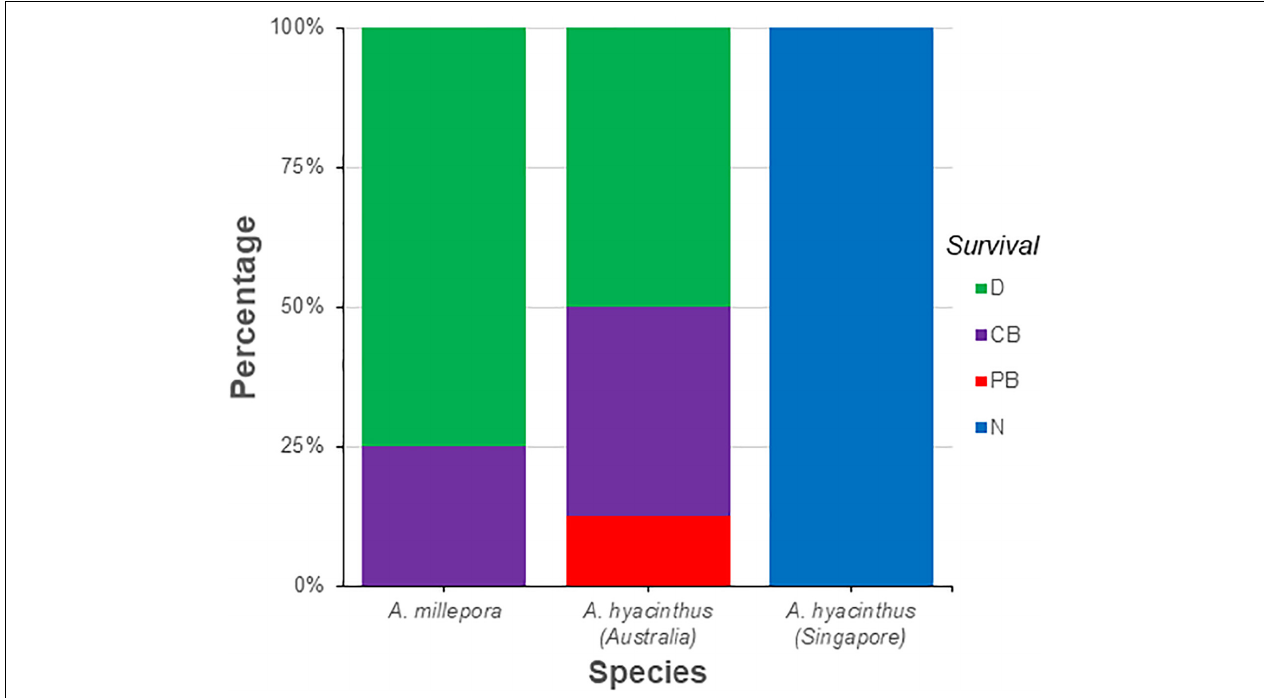
FIGURE 6 | Post temperature stress survival (%) of Acropora millepora and Acropora hyacinthus colonies from the two geographical locations (Australia and Singapore). N, not bleached; PB, partially bleached; CB, completely bleached; D,